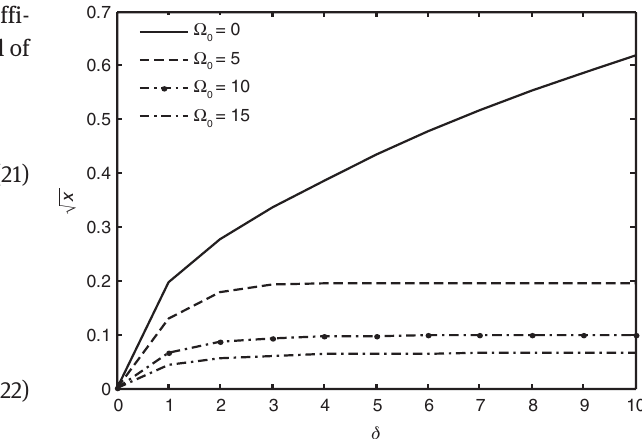
Figure 1: Variations of non-dimensional phase speed ( ) x against non-dimensional constant δ for impedance parameters δ = −5. δ 2